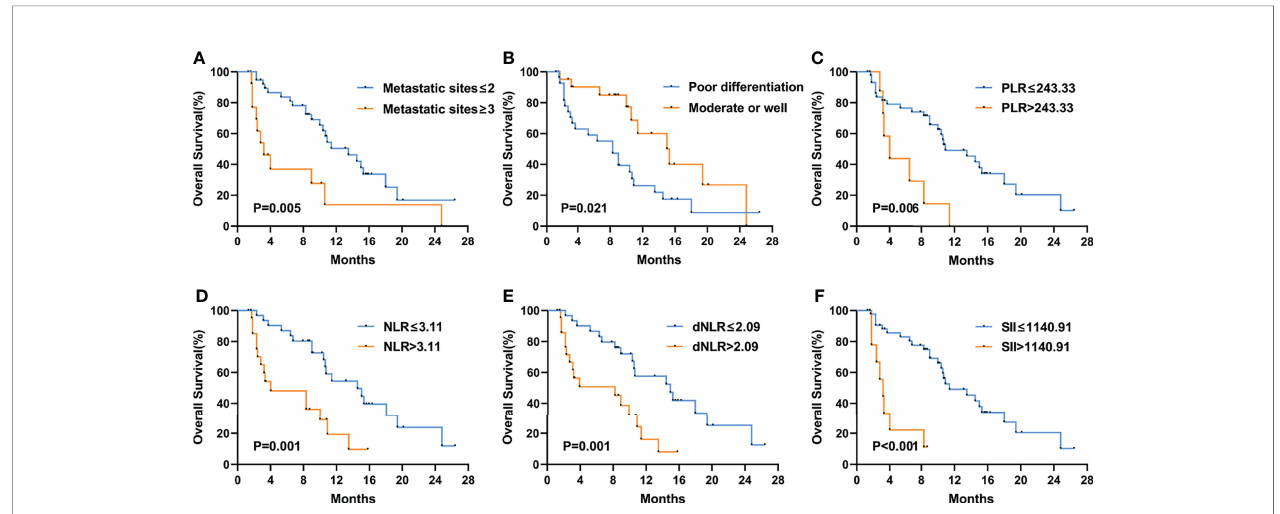
FIGURE 5 | Kaplan – Meier curves of overall survival (OS) in the second-line or posterior treatment according to metastatic sites (A) , differentiation (B) , PLR (C) , NLR (D) , dNLR (E) , and SII (F) at baseline. The P values were calculated using the log-rank test